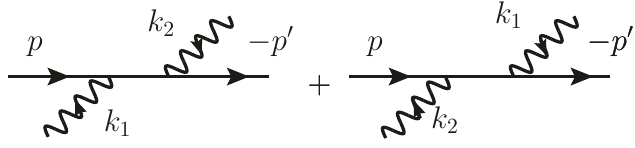
Figure 3 . Feynman diagrams for the Compton scattering amplitude in the standard formalism.